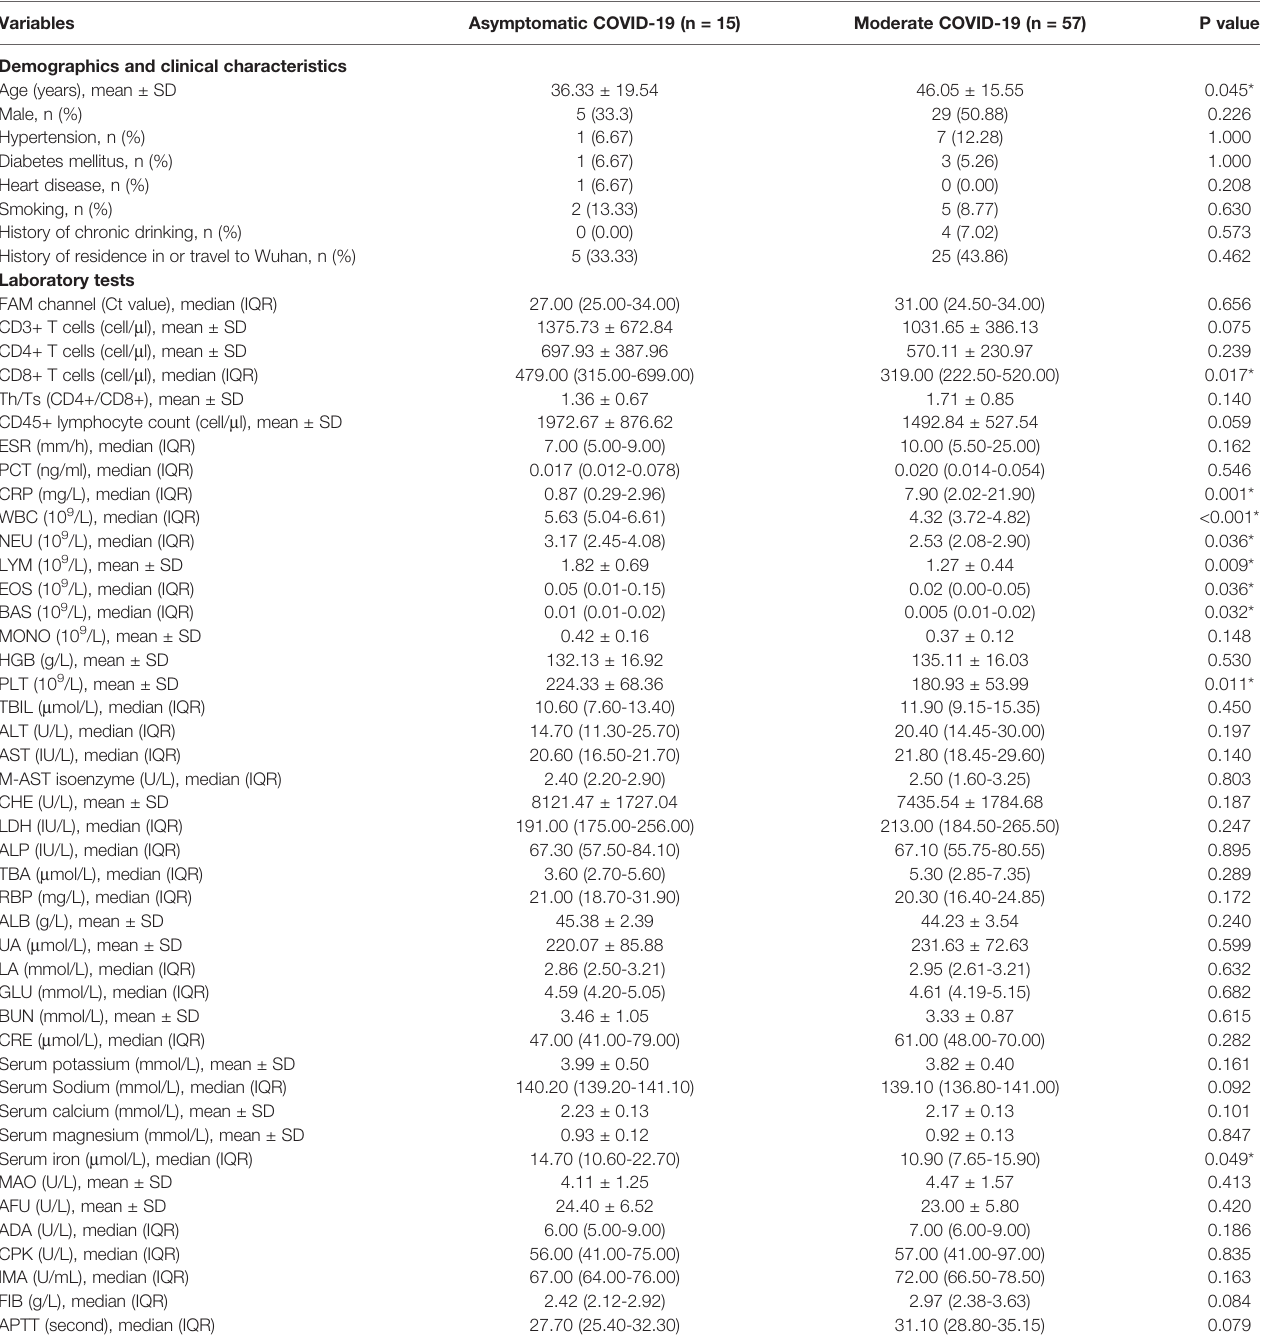
TABLE 1 | Baseline demographic, clinical, and laboratory characteristics of patients with asymptomatic COVID-19 and patients with moderate COVID-19. Variables Asymptomatic COVID-19 (n = 15) Moderate COVID-19 (n = 57) P value Demographics and clinical characteristics Age (years), mean ±